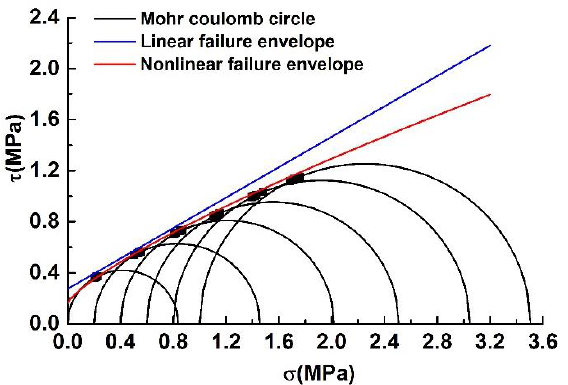
 −  − space at 60 °C. space at 60 °C.